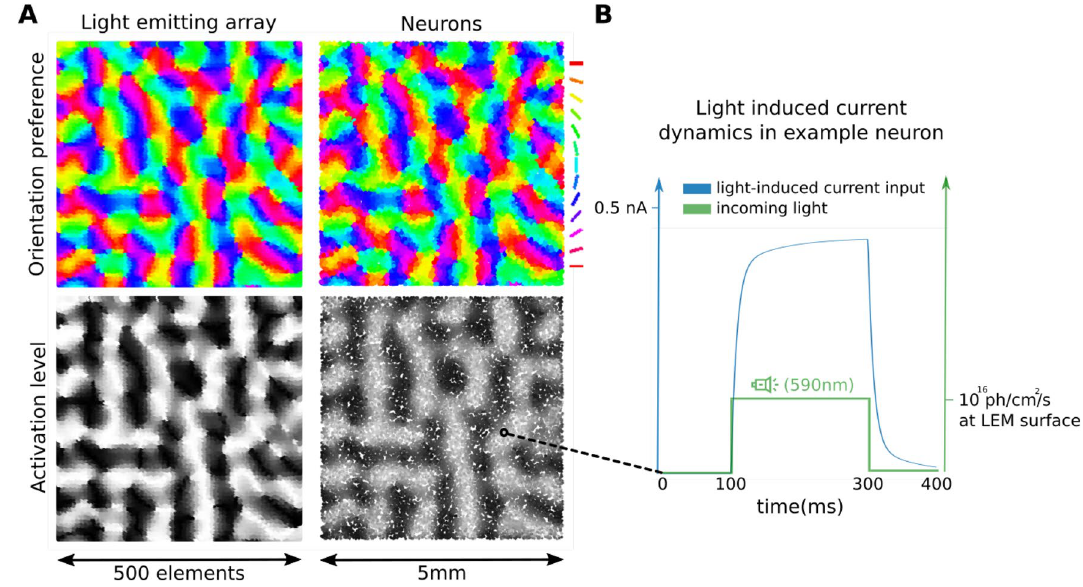
Figure 3. Opto-stimulation protocol for grating stimului. ( A ) The assigned orientation preference to individual light emitting elements and the orientation preference of neurons (top row). The driving signal to individual light-emitting elements imposed by the optogenetic stimulation protocol and the resulting depolarization in cortical tissue (bottom row). ( B ) The light output of an example light-emitting element (green) and the resulting light-mediated inward current to an example neuron located at the same location (blue).